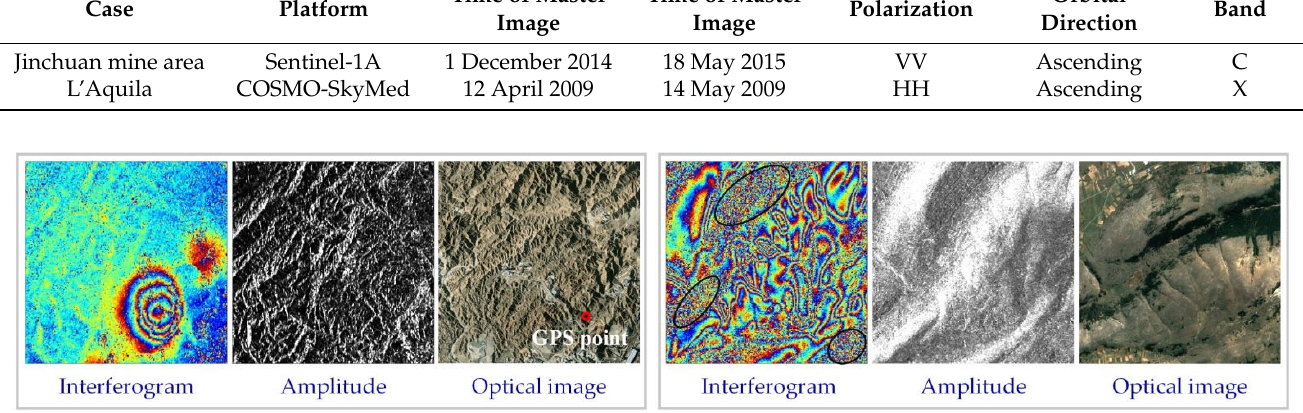
Figure 5. Interferogram, amplitude, and optical images of Jinchuan mining and L’Aquila city. In the Jinchuan mine area, the amplitude image is from the sentinel-1A image on 1 December 2014, the optical image is from google earth’s historical image on 31 December 2014, and the latitude is from 38°27’49” N to 38°28’58” N, the longitude is from 102°09’15” E to 102°10’24” N. In L’Aquila, the amplitude image is from the COSMO-SkyMed image on 12 April 2009, the optical image is from google earth’s historical image on 8 May 2009, and the latitude is from 42°14’56” N to 42°15’48” N, the longitude is from 13°38’30” N to 13°39’18” N.